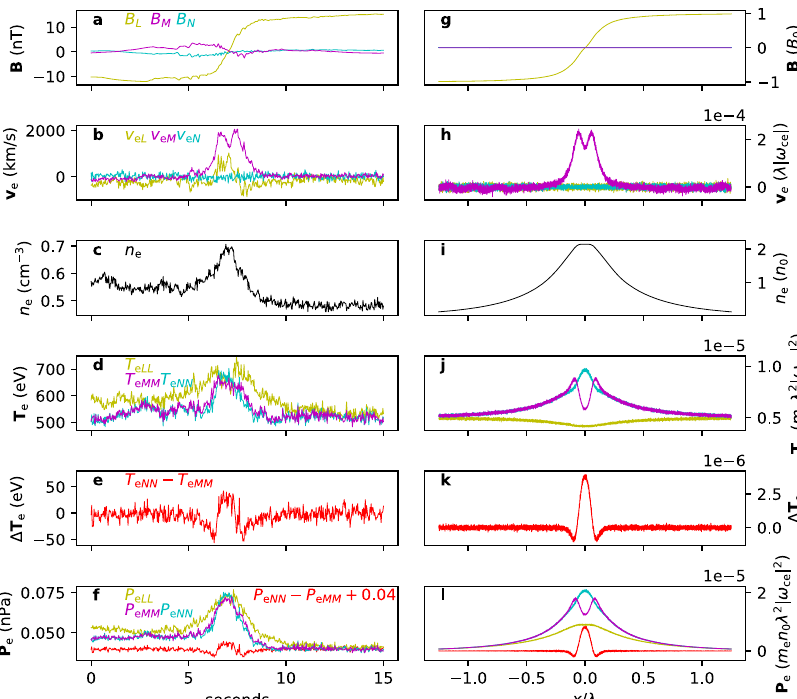
Fig. 5 Comparison of a current sheet detected by MMS to that from the particle-in-cell simulation. a – f Sequentially, the magnetic fi eld B , electron velocity v e , electron density n e , diagonal elements of the electron temperature tensor T e , the difference between the temperature tensor elements T e NN − T e MM , and diagonal elements of the electron pressure tensor P e and P e NN − P e MM (shifted up by 0.04) detected by the Magnetospheric Multiscale spacecraft from 20:24:00 to 20:24:15 UT on 17 June 2017. The x axis is seconds from 20:24:00 UT. The current sheet crossing velocity is ~67km/s, so one second corresponds to 67km, or 9 d e . g – l Quantities from the particle-in-cell simulation respectively corresponding to a – f . The x axis is in units of λ = 10 d i = 100 d e